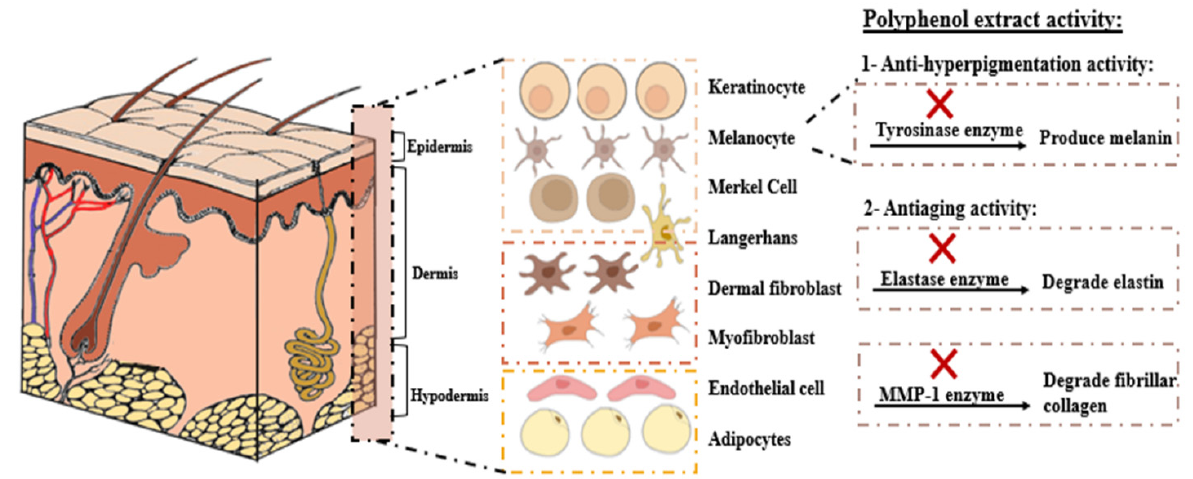
Figure 4. Effects of phenolic extracts on the skin anti-hyperpigmentation activity by inhibting tyrosinase enzyme as well as on the antiaging property by inhibting elastase and MMP-1 enzymes.